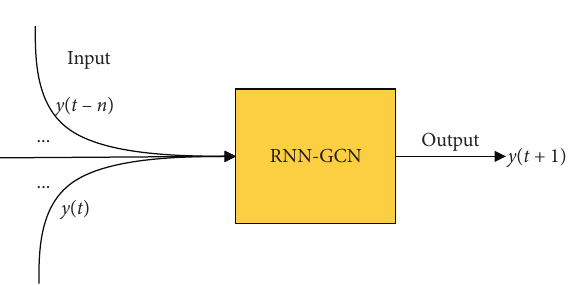
Figure 2: BRB fusion process.